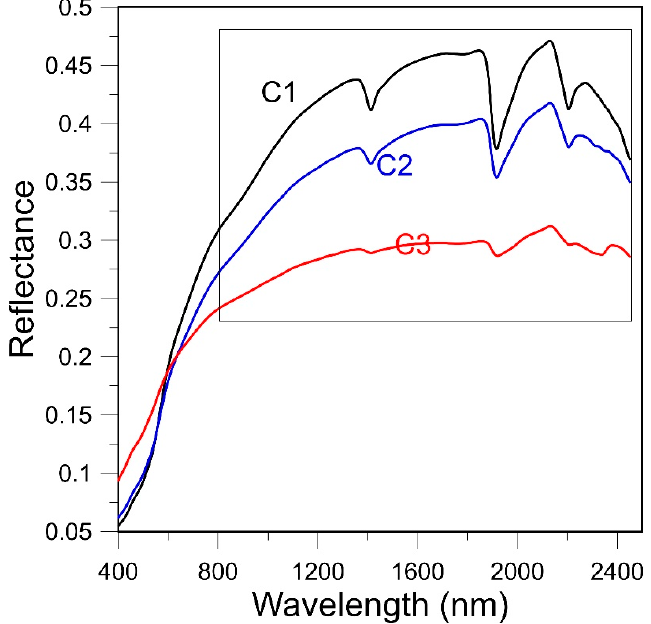
Figure 4. Average reflectance (R) spectra of soils from the three clusters (C1, C2, C3) resulting from the application of PCA and Cluster analysis to the investigated soil properties.